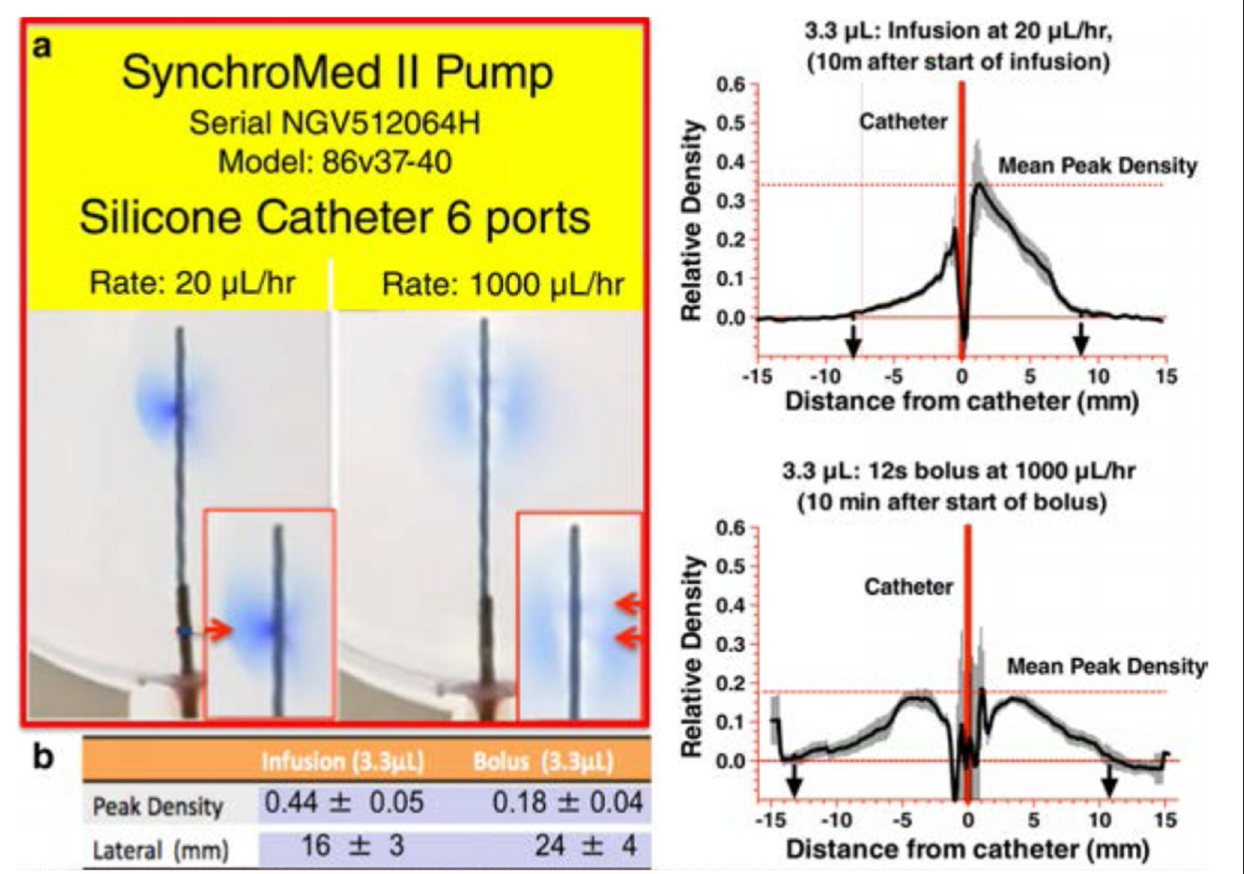
FIGURE 7 | [ (A,B) Left] A photograph of the 2D diffusion chamber, showing movement of blue dye from the catheter (Model 8709SC) connected to a SynchroMed II pump. The most proximal (to the pump) pair of ports is located at 180 ◦ from each other, and the catheter is arranged so that the axis of these first two ports is parallel with bottom of the chamber. An image taken at 10min after the start of a continuous infusion of 2% methylene blue dye at 20 µ L/h, delivering 3.3 µ L. (Right): 10min following the bolus delivery of 3.3 µ L at 1,000 µ L/h. b. Mean ± SEM ( N = 5 replications) densitometry measurements (arbitrary units) across a line perpendicular to the catheter at the point of dye exit from the first port proximal to the pump as shown in the left and bolus as shown in the right [reprinted by permission from Hildebrand et al. ( 175),